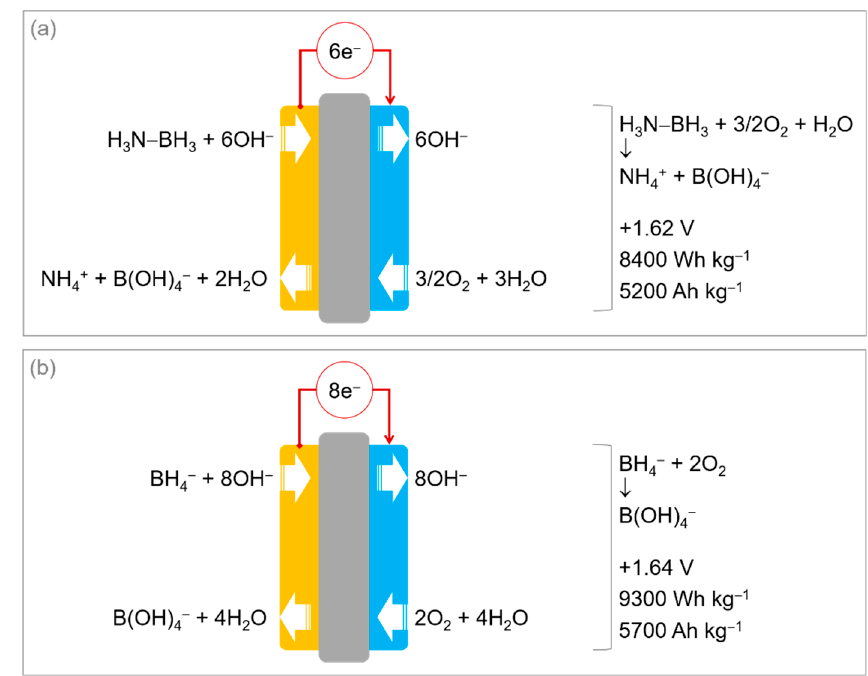
Figure 2. Schematic representation of ( a ) the direct ammonia borane fuel cell and ( b ) the direct borohydride fuel. At the right is given the standard potential versus the standard hydrogen electrode, the specific energy and the pure compound capacity. The anode (in yellow) and the cathode (in blue) are separated by a mmebrane (in grey).